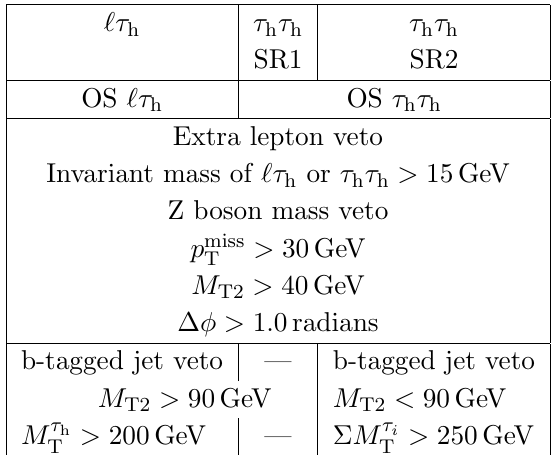
Table 1 . De(cid:12)nition of the signal regions.